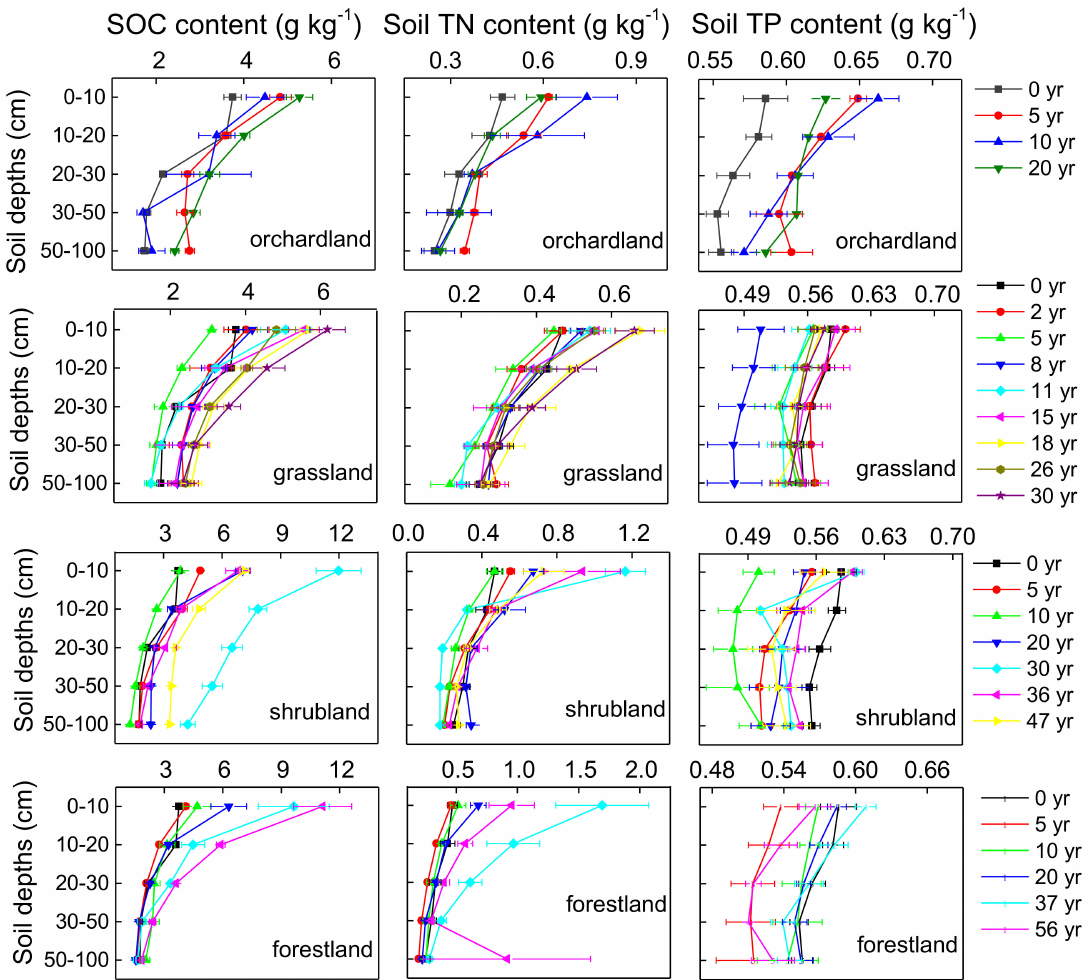
Figure 6. Vertical distributions of soil organic carbon (SOC), soil total nitrogen (TN), and soil total phosphorus (TP) contents for different vegetation types. Note: values are mean ± standard